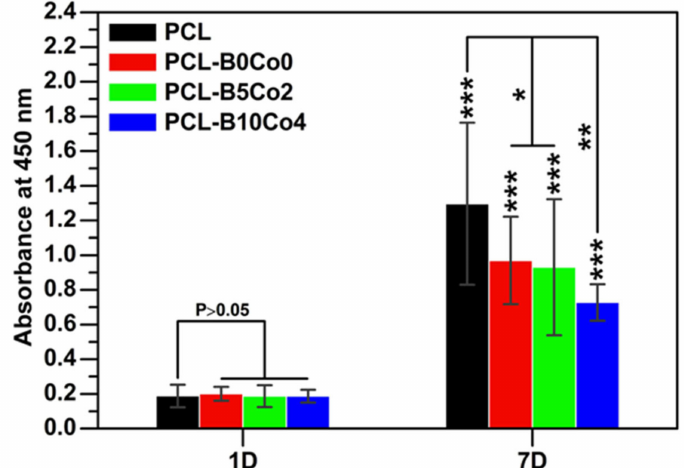
Figure5. WST-8resultsfrom cellcultureexperiments with ST-2cellsdirectly culturedonPCL-BCo.BGNs